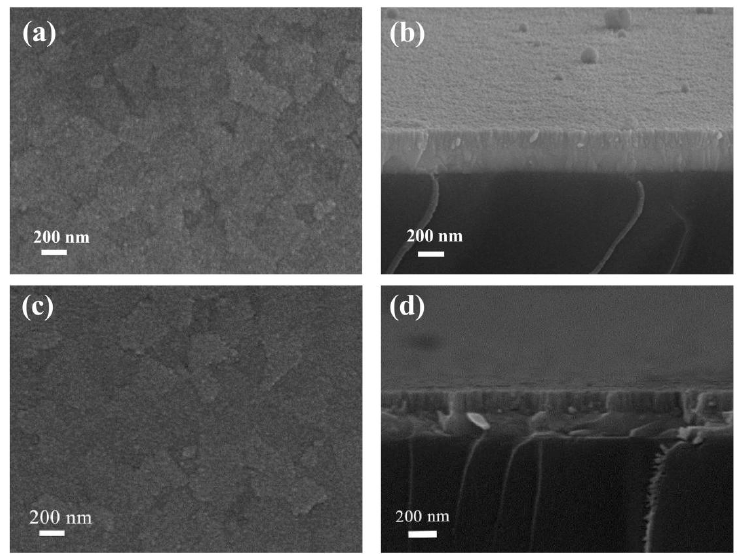
Figure 2. SEM images of the NiO and W-NiO films. ( a ) Surface and ( b ) cross-sectional SEM images of the NiO film. ( c ) Surface and ( d ) cross-sectional SEM images of the W-NiO film. The crystal structure of the NiO and W-NiO films on the ITO-coated glass is investi- gated by XRD, as exhibited in Figure 3a. Both the prepared films show the diffraction peaks of the ITO substrate (JCPDS 65-3170) [27]. A characteristic peak at around 43° can be observed in the patterns of NiO and W-NiO films, which is corresponding to the (200) plane (JCPDS 73-1519) of cubic NiO [28]. In addition, compared with pure NiO film, the diffraction peak of the W-NiO (200) plane shows a shift to high angle, indicating that the interplanar spacing becomes smaller after being doped by W, because the ionic radius of W (0.62 Å) is smaller than that of Ni (0.69 Å) [29]. Moreover, no other characteristic peaks corresponding to W or the W compound are detected in the W-NiO film, which implies that W is completely incorporated into the lattice of NiO or the W compound exists in amorphous form in the W-NiO film.